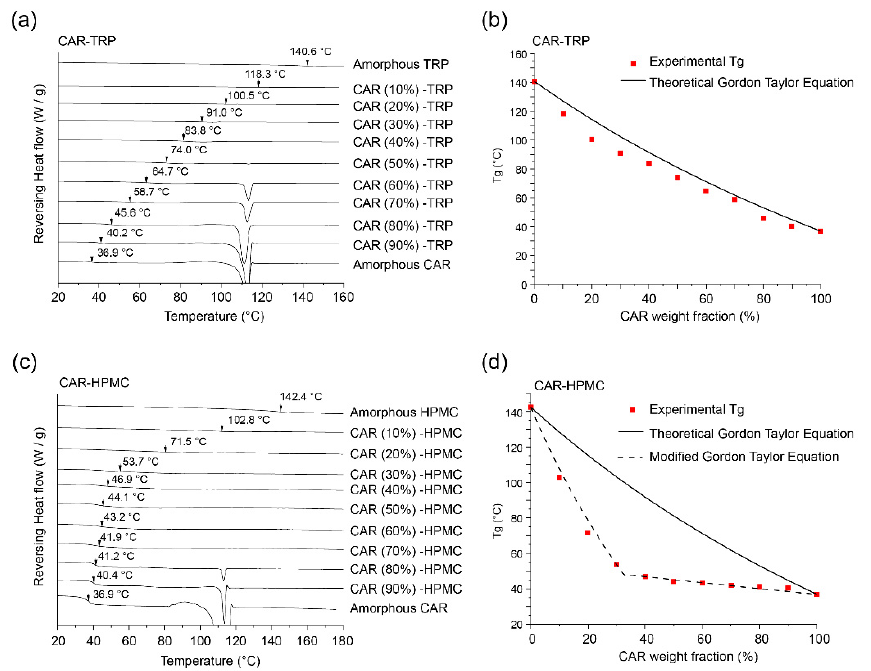
Figure 1. mDSC thermograms (reversing heat flow) of ( a ) co-amorphous CAR-TRP and ( c ) CAR- HPMC systems. The experimental T g s are indicated by arrows. ( b ) Comparison of experimental and theoretical T g values of co-amorphous ( b ) CAR-TRP and ( d ) CAR- HPMC systems.